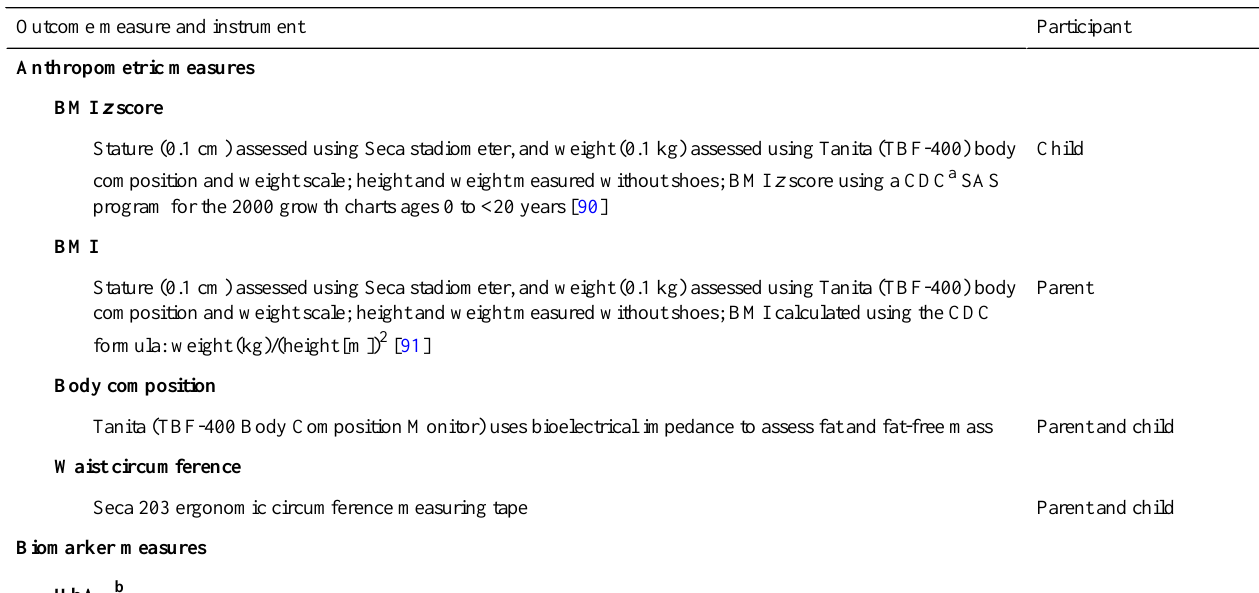
Table 1. Pilot trial outcome